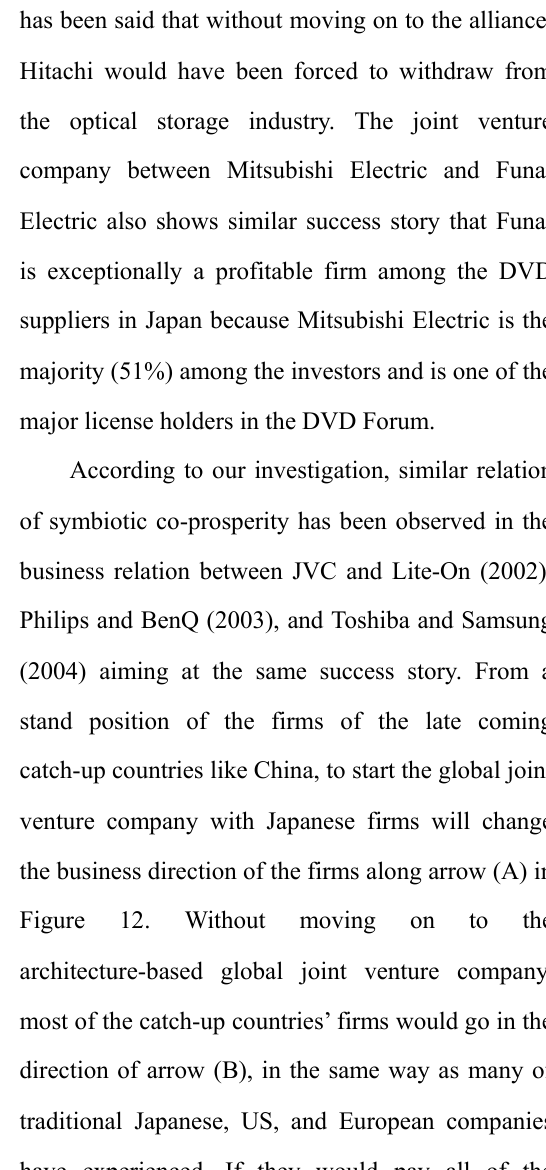
12. Without moving on to